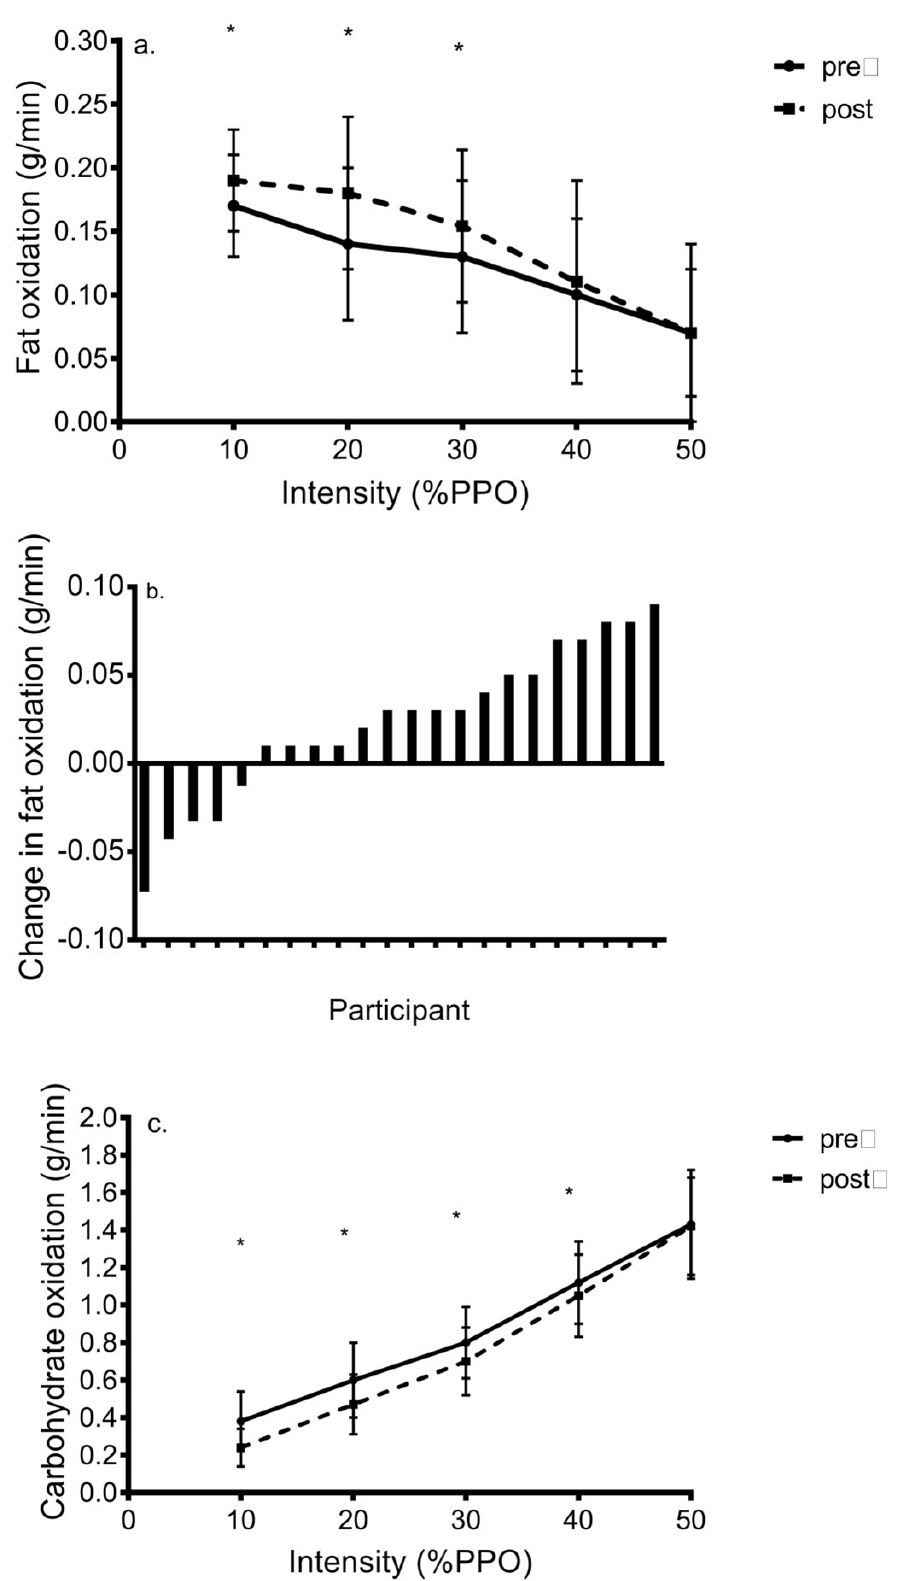
Figure 2. Change in ( a ) fat oxidation, ( b ) individual changes in maximal fat oxidation in response to low volume HIIT, and ( c ) CHO oxidation during progressive exercise in response to low-volume HIIT in inactive women (mean ± SD). * = p < 0.05 versus pre-training